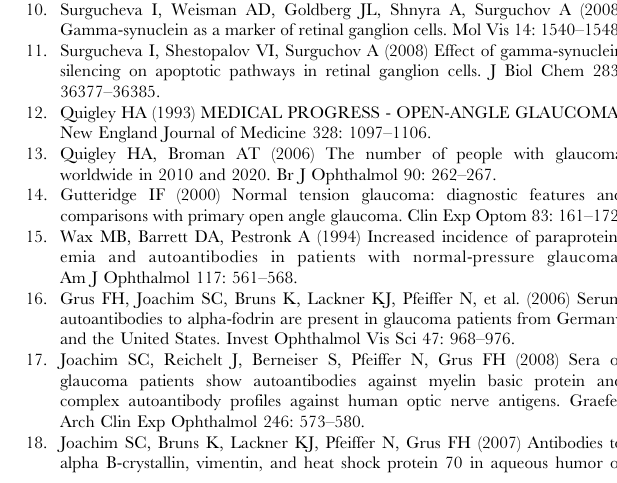
Figure S1 Expression of c -synuclein in RGC5 revealed by indirect immunofluorescence RGC-5 cells were fixed, permeabilised, blocked and incubated with sheep polyclonal anti c -synuclein abs. Subsequently the cells were incubated with rabbit anti sheep IgG-H&L conjugated with FITC. Nuclei staining were performed with DAPI and cells were visualized with a fluorescence microscope. c -synuclein was expressed in all cells and it seems to be distributed in the cytoplasm. (TIF) Figure S2 Regulation of mitochondrial apoptosis asso- ciated proteins. RGC-5 cells were preincubated with 0.5 m g/ml c -synuclein abs and subsequently lyzed, tryptically digested before protein analysis via Microarray was performed. The differences were calculated in comparison to control cells, which were untreated. (n =12, *= p , 0.05; **p , 0.01). (TIF) Table S1 Significant protein changes in c -synuclein antibody treated